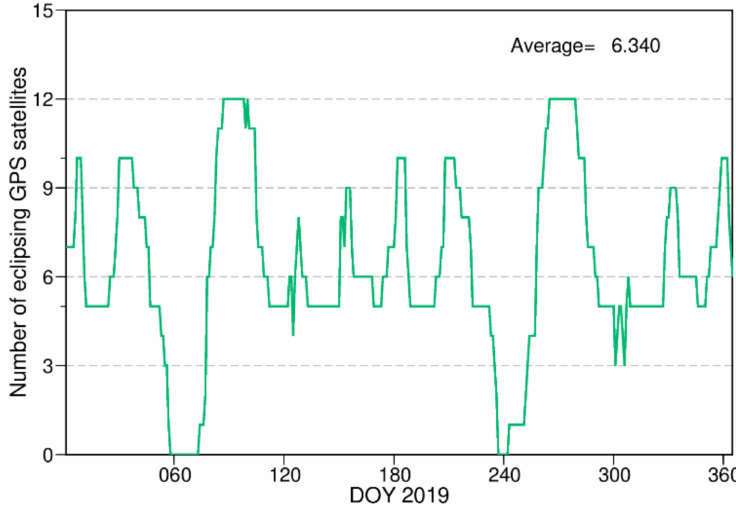
Figure 1. Daily number of GPS satellites in eclipse seasons in